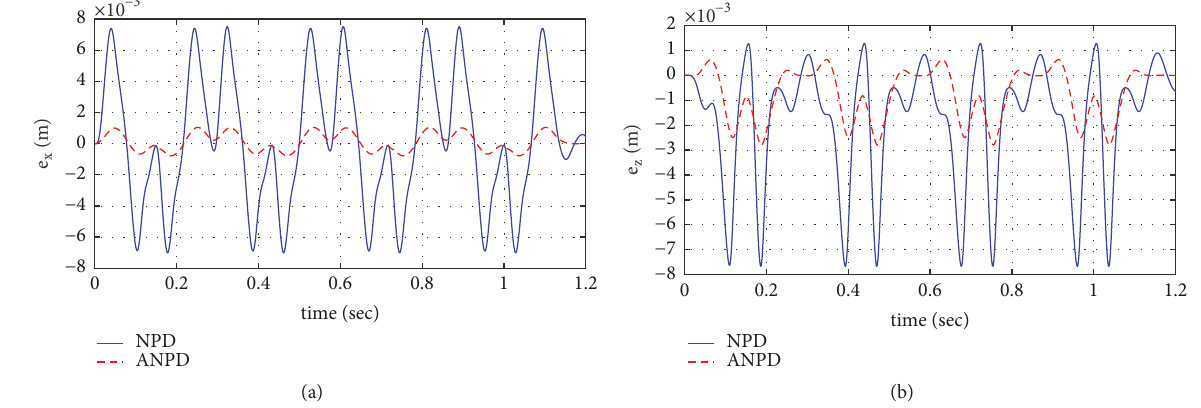
Figure 10: Torque responses for APD and ANPD controllers.